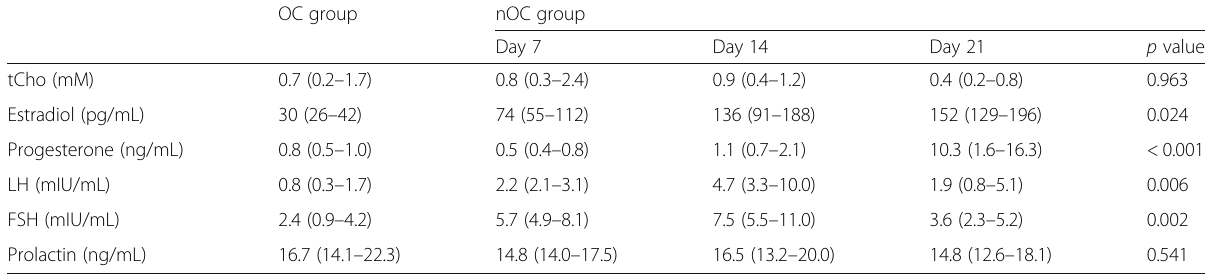
Data are medians and interquartile intervals. In the nOC group, three measurements were made on days 7, 14, and 21 of the menstrual cycle *This comparison was made among the three distributions measured in the nOC group as a variation during the menstrual cycle